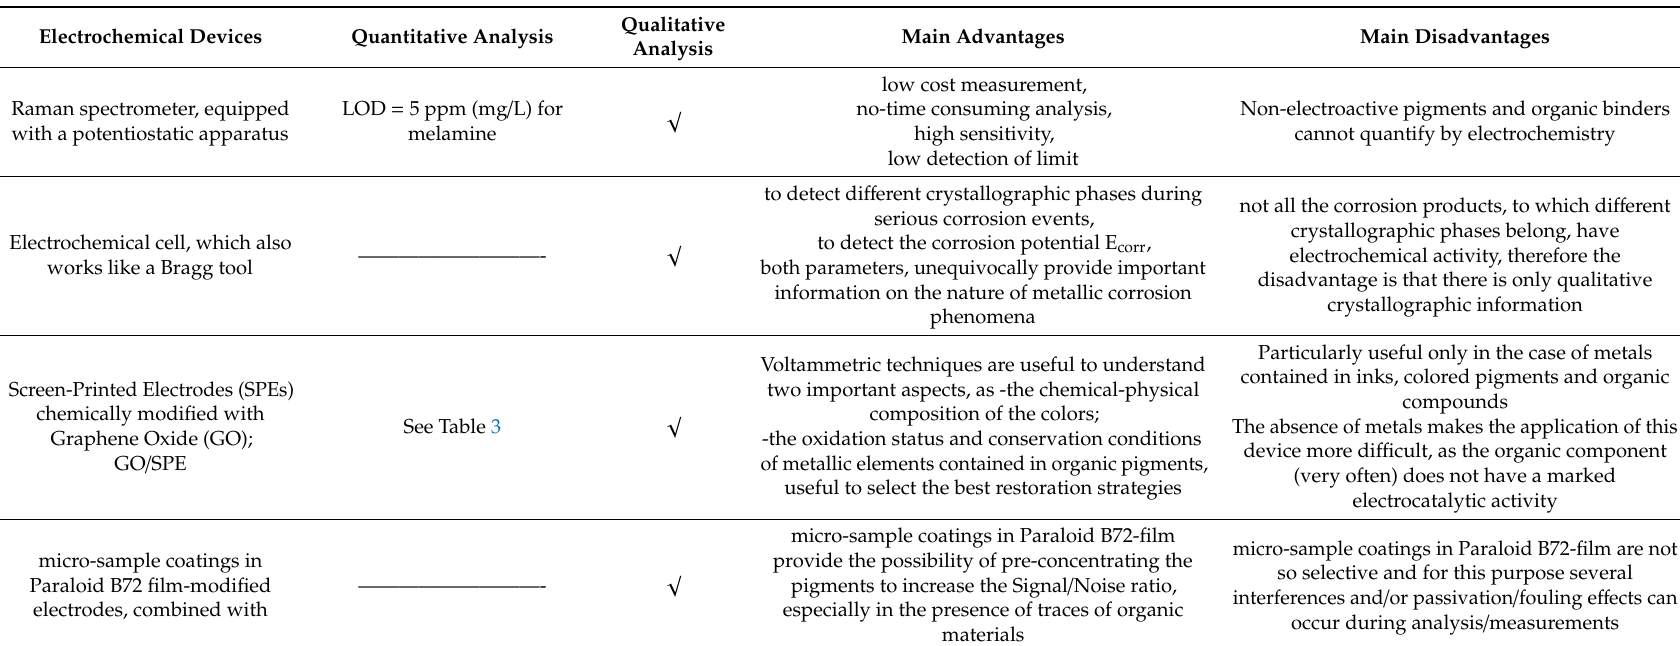
Table 4. Main characteristics of the most important electrochemical sensors applied in CH, mainly presented in this